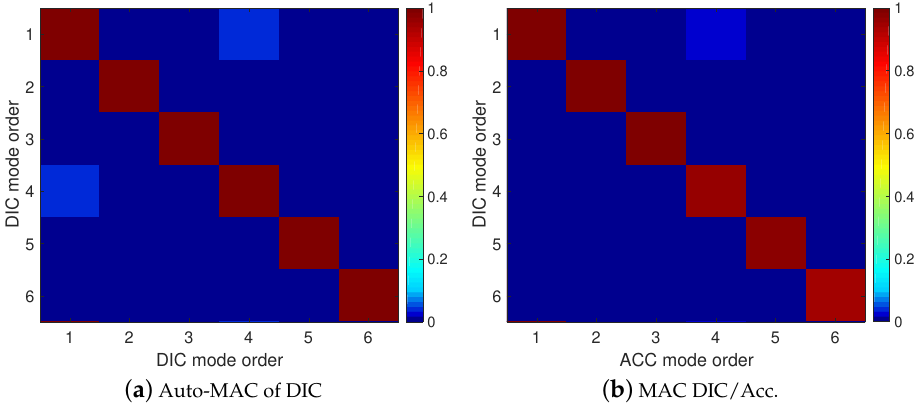
Figure 21. Components of the MAC matrix calculated from measurements: ( a ) auto-MAC of mode shapes obtained from DIC measurements and ( b ) MAC of mode shapes obtained from accelerometer and DIC